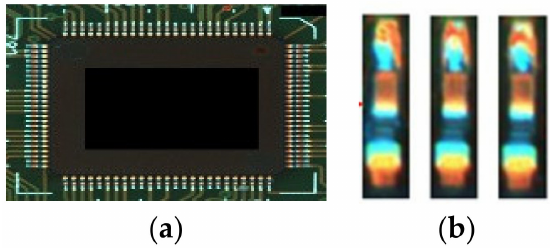
Figure 1. ( a ) PCB with solder joints; ( b ) Extracted soler